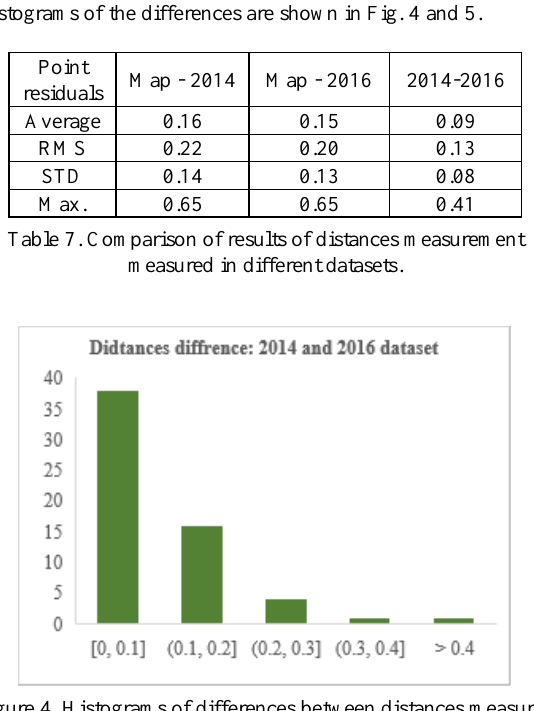
Figure 4. Histograms of differences between distances measured on both oblique image